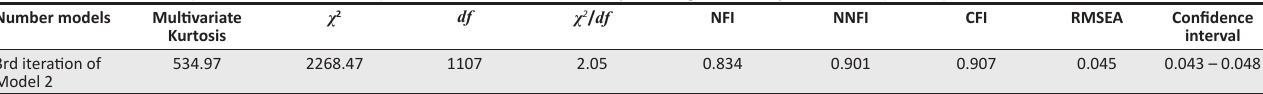
TABLE 5: Goodness-of-Fit (Yuan–Bentler correction) indices for Structural Model 2 predicting individual performance ( n = 509). Number models